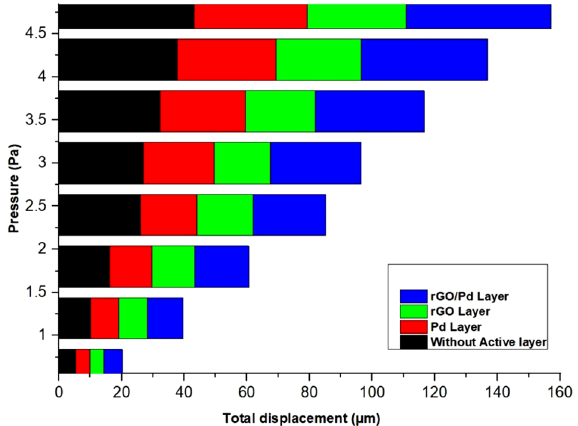
Figure 16. A displacement comparison of all four design for the same applied pressure.